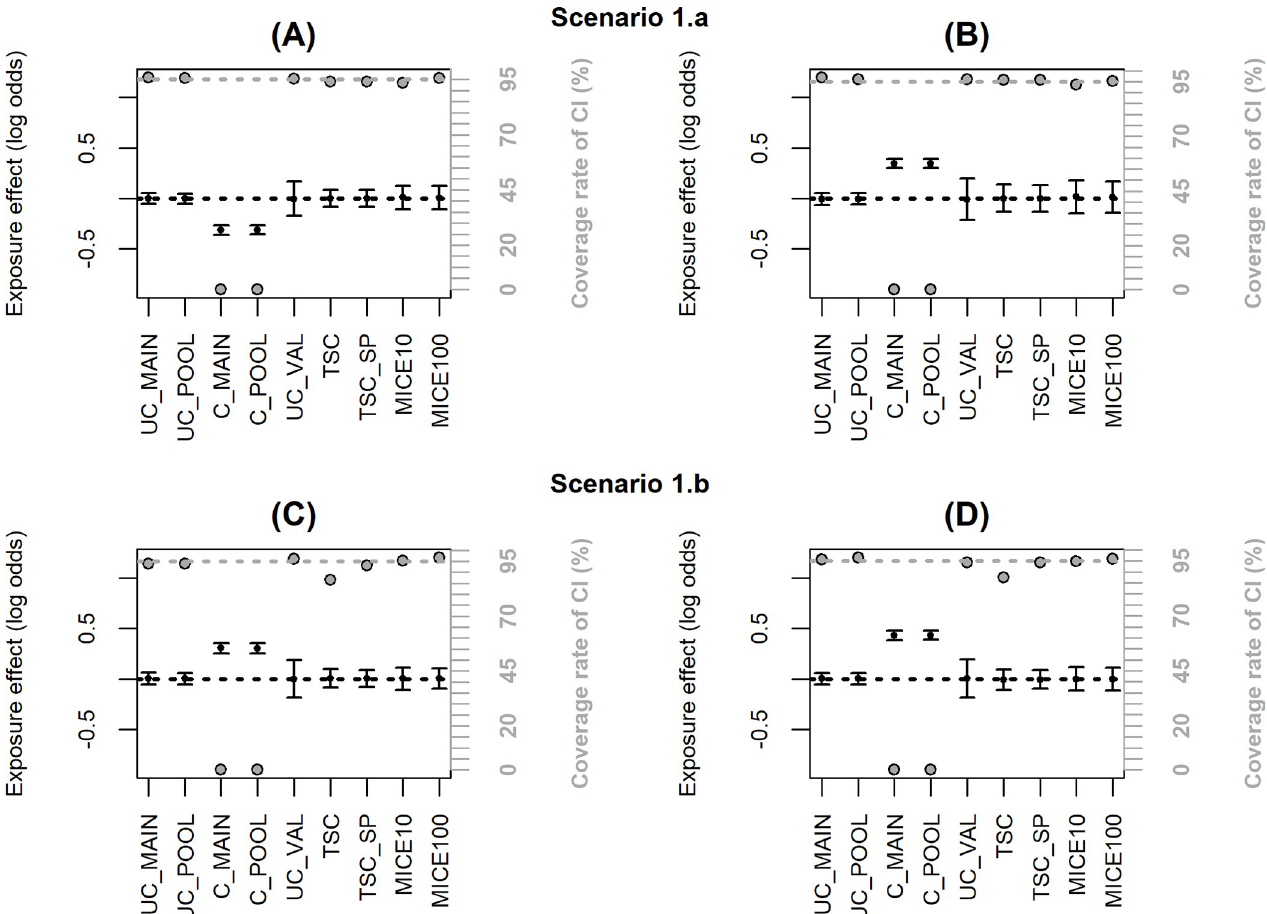
Fig 2. Simulation results with a representative external validation sample (scenario 1); coverage rate of 95% confidence interval (grey dot with black margin) and mean estimated log-odds ratio for the exposure effect (black dot) ± empirical standard error: (A) two unobserved Gaussian confounders, (B) five unobserved Gaussian confounders, (C) two unobserved non-Gaussian confounders, (D) five unobserved non-Gaussian confounders. The grey dotted line corresponds to the nominal value of the coverage rate of the 95% confidence interval. The black dotted line is the true value of β (0).